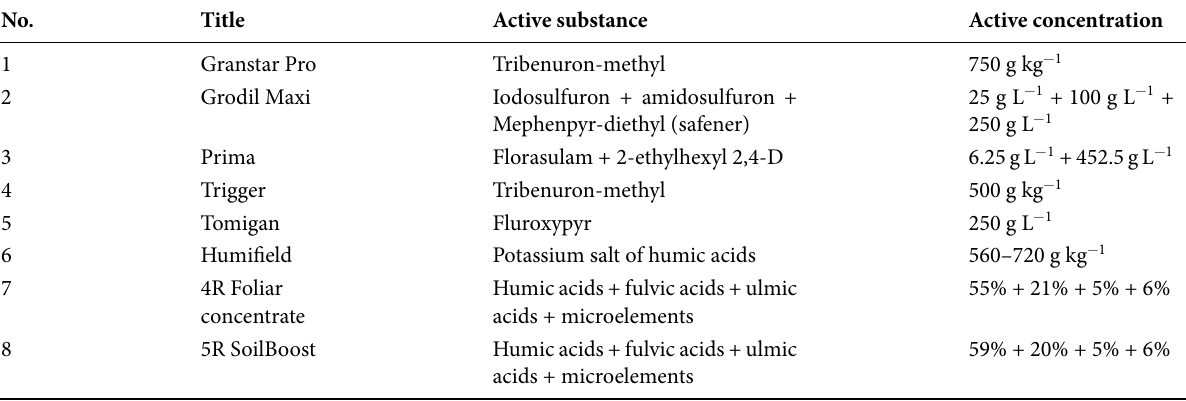
Table 1 Investigated herbicides and humic growth regulators.